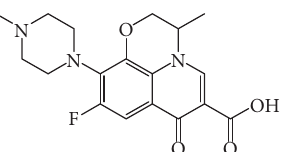
Scheme 1: The chemical structure of